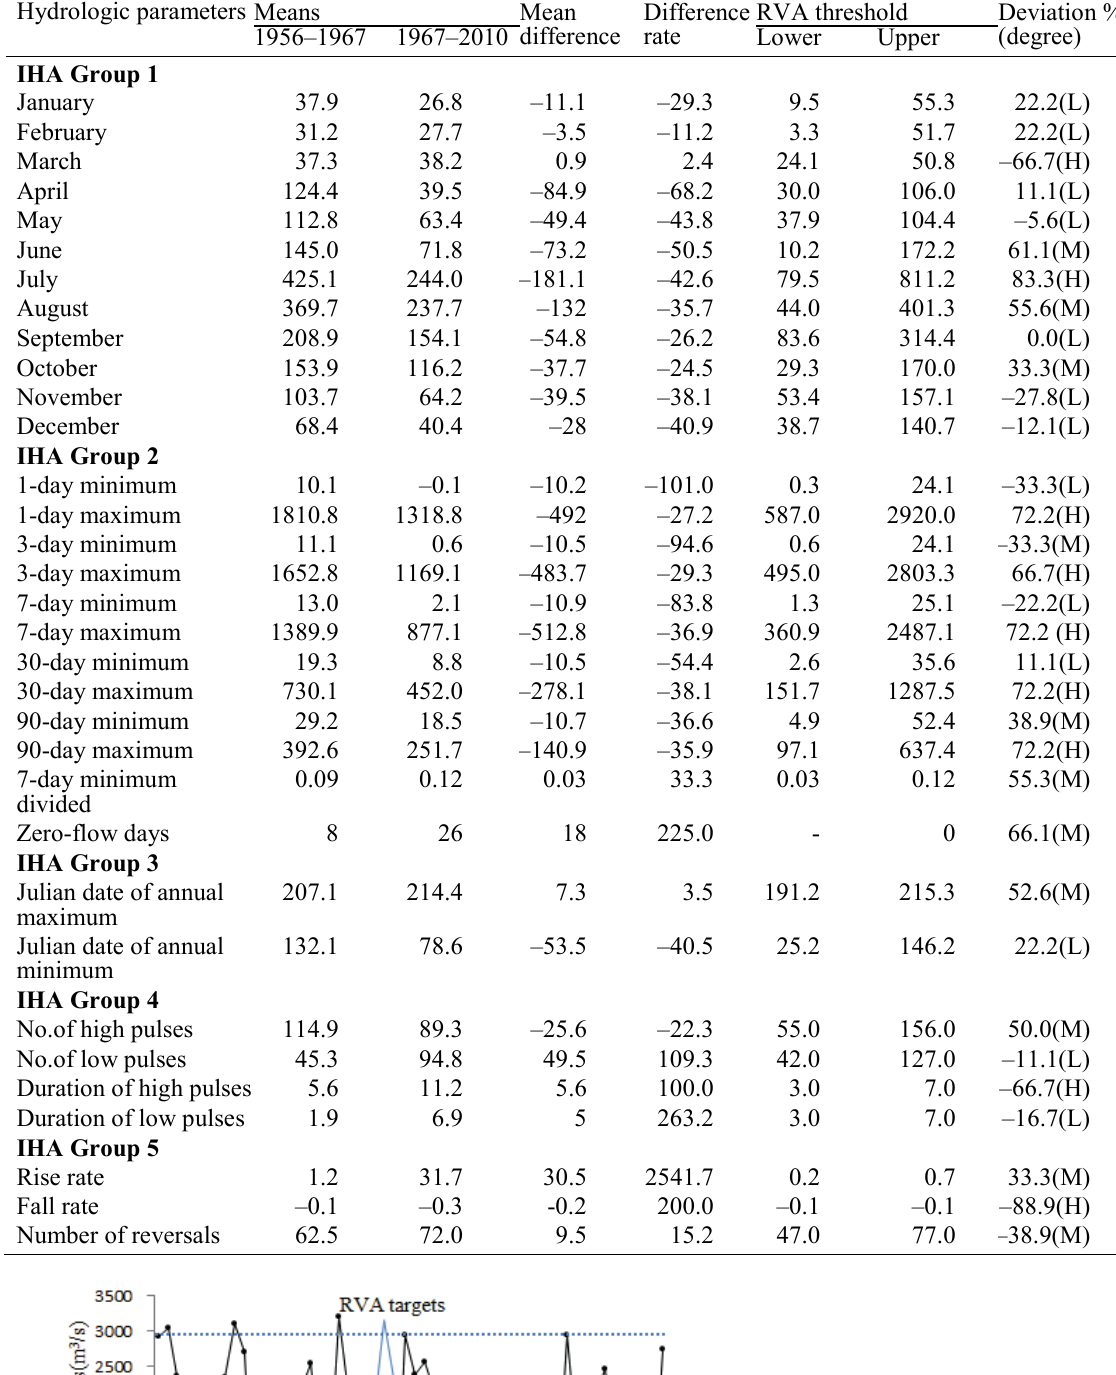
Table 1 Alteration of the 33 hydrologic parameters.